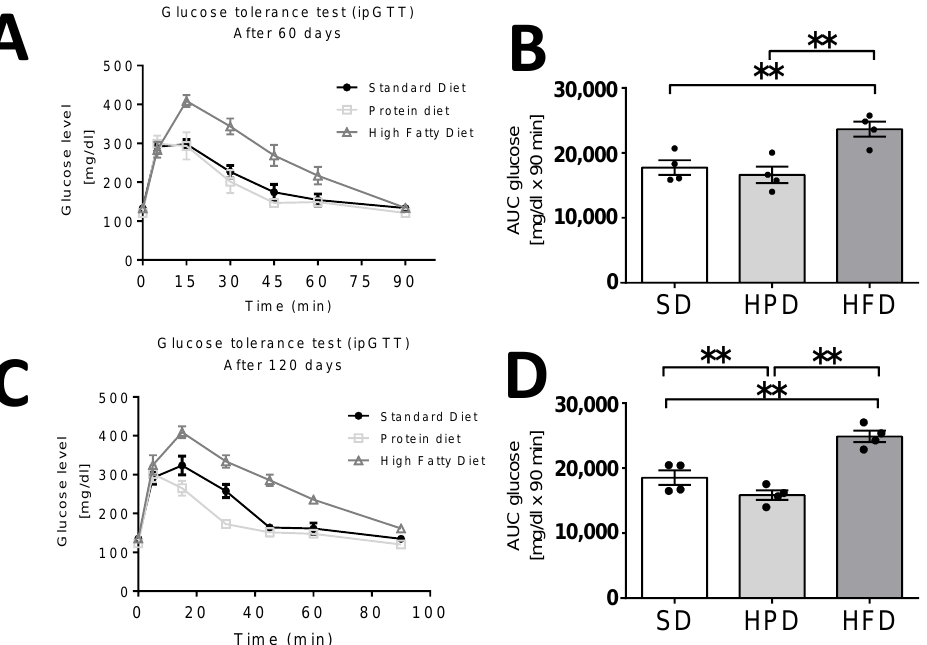
Figure 2. The effects of three different diets on glucose utilization rate ( ip GTT) after 60 ( A , B ) and 120 days ( C , D ). ( B , D ) show mean areas under glucose curves. Results are means ± SEM for n = 4; significant differences are marked for p < 0.01 (**).